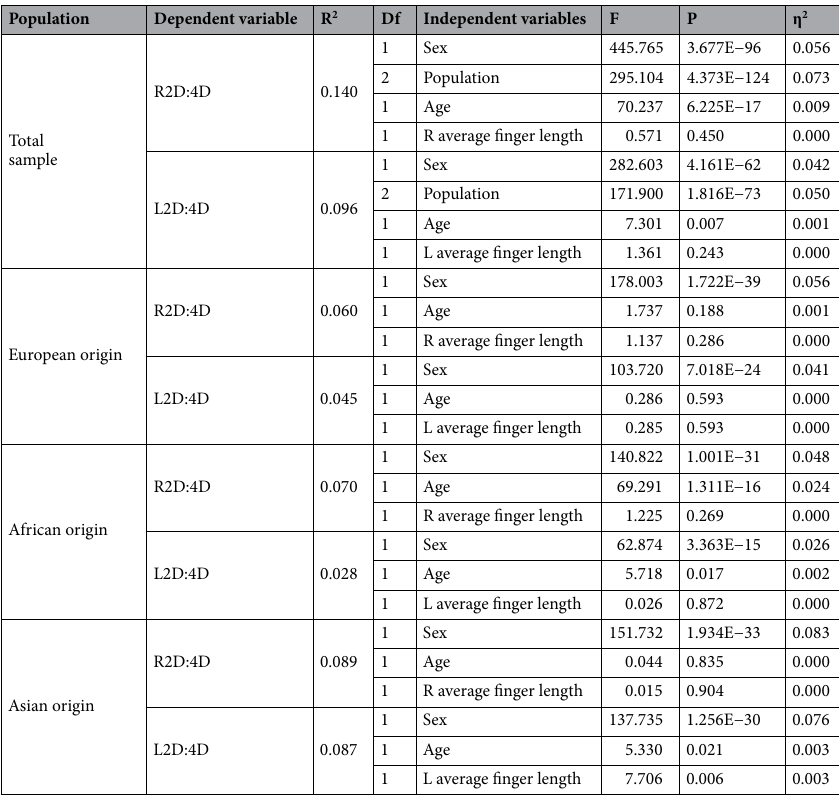
Table 2. The GLM ANCOVA analyses for outcome variables the right and left 2D:4D ratios and sex, population, age, average finger length for the right and left hand in the whole sample, and sex, age, average finger length for each population. R 2 R Squared, df degrees of freedom, F F test statistics, p statistical significance, η 2 Partial Eta Squared effect